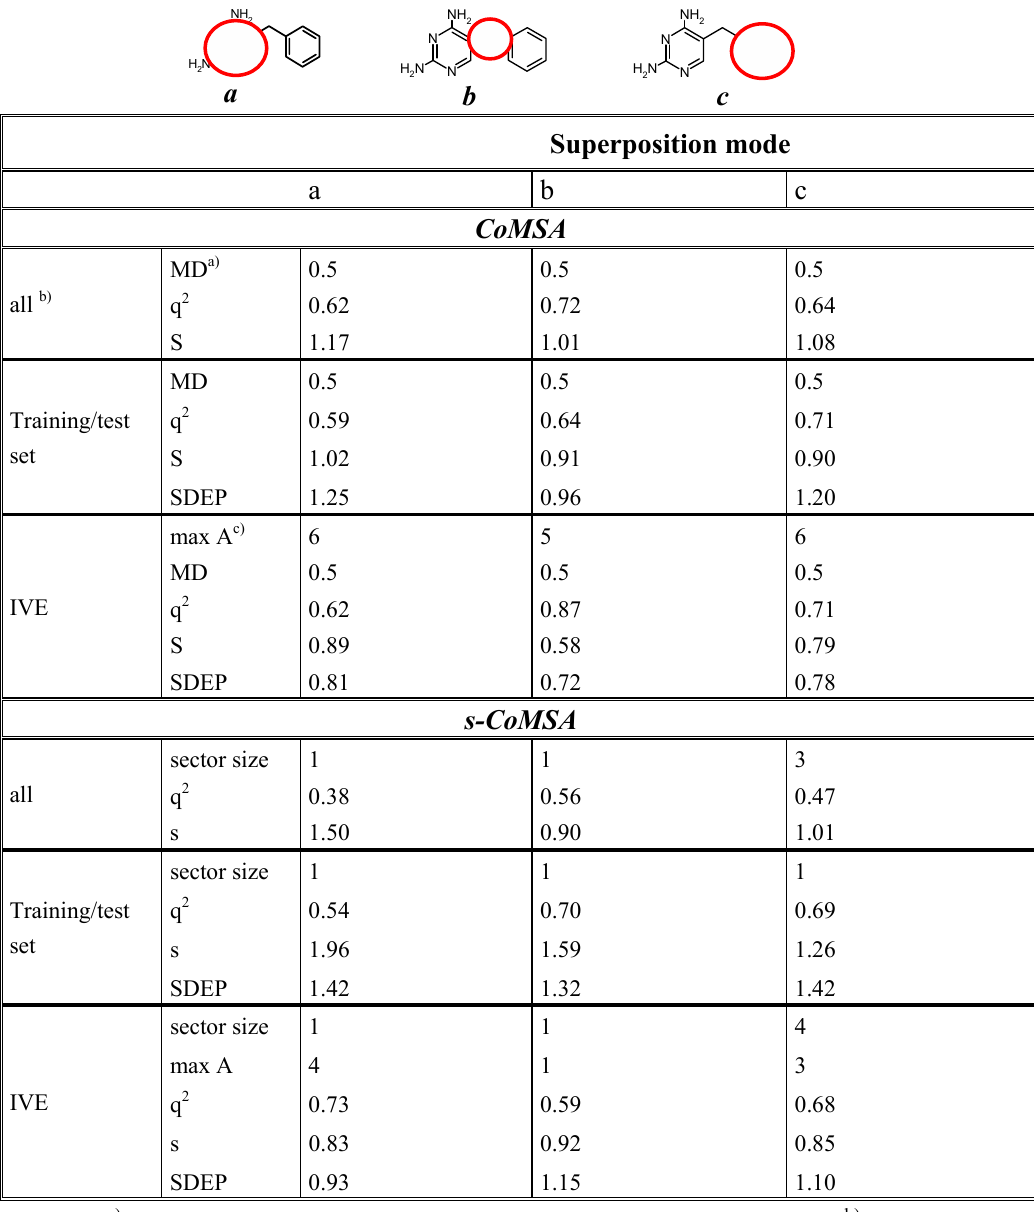
Table 2 . 3D QSAR